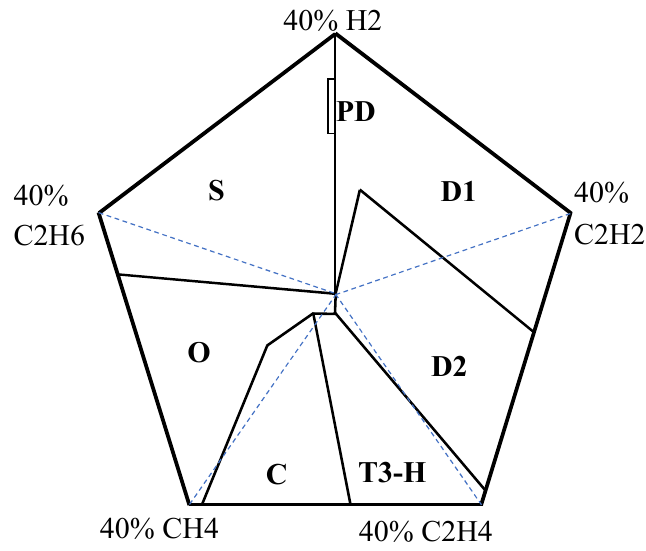
Figure 1. Duval pentagon method (DPM).